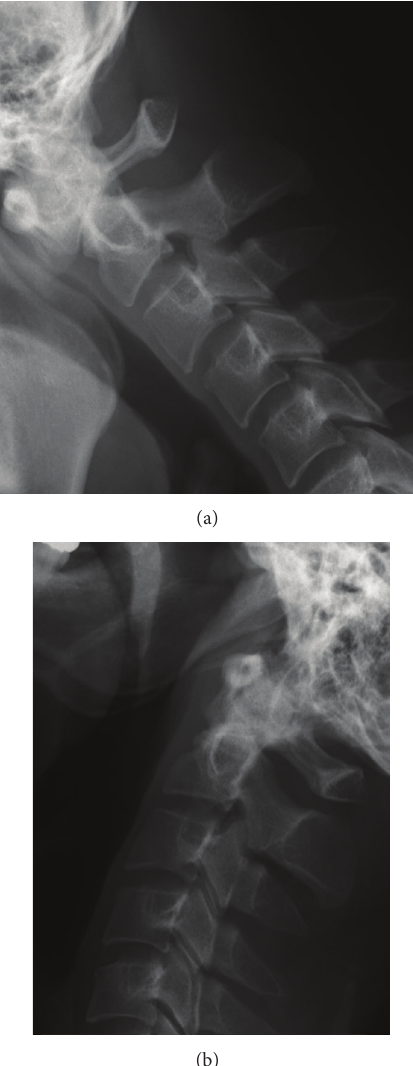
Figure 1: Plain X-ray images at the first visit under (a) flexion and (b) extension. Instability of the atlantoaxial joint was observed, with ADI increasing to 8mm under flexion and reducing to ≤ 3mm in extension.